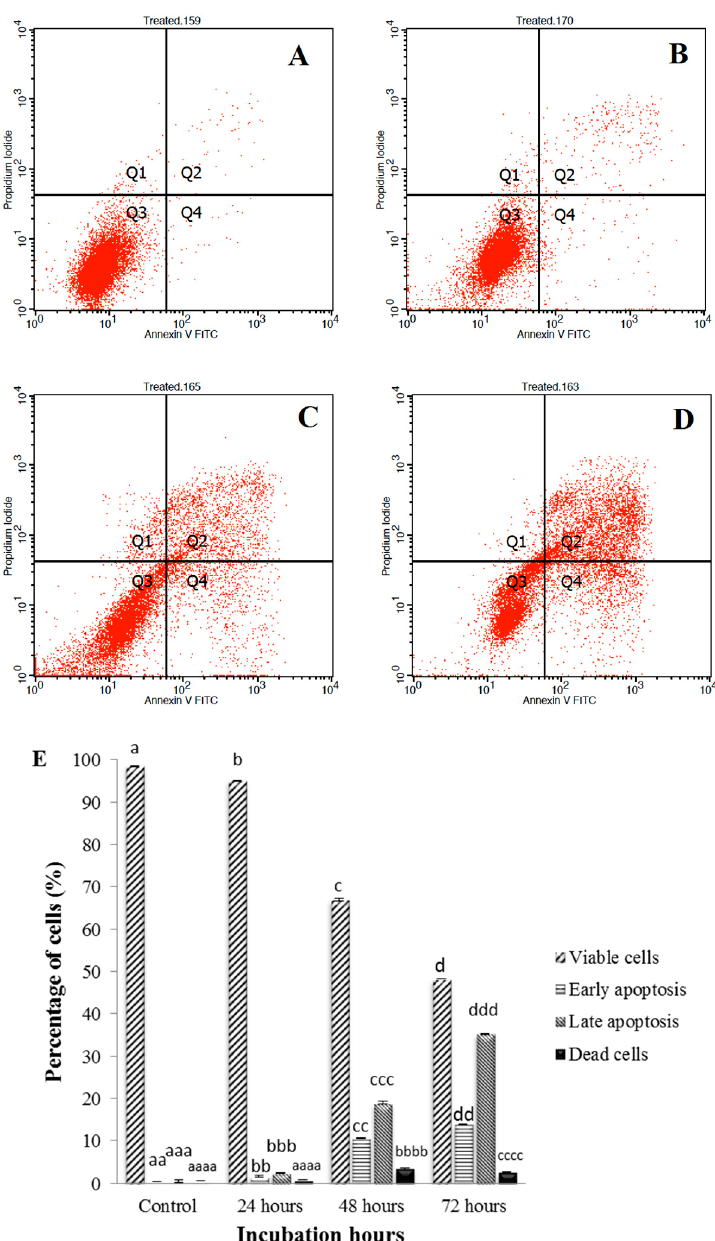
Figure 3. Annexin V-FITC analysis of HepG2 cells untreated ( A ) and treated with sulforaphene (33.8 µ M) for 24 ( B ), 48 ( C ) and 72 ( D ) hours. Cells were cultured in serum free RPMI-1640 medium and maintained at 37 °C and 5% CO 2 . Results represent one of three independent experiments. Early apoptosis (Annexin +/PI − ) is shown in the lower right quadrant (Q4) for each panel while late apoptosis (Annexin+/PI+) is shown in the upper right quadrant (Q2). Viable cells are represented in the lower left quadrant (Q3). Necrosis (Annexin − /PI+) is shown in the upper left quadrant (Q4). Chart comparison of cell distribution after sulforaphene treatment at 24, 48 and 72 h ( E ). Values are presented as means ± SD of triplicate experiments, and means with different letters differ significantly ( p < 0.05).